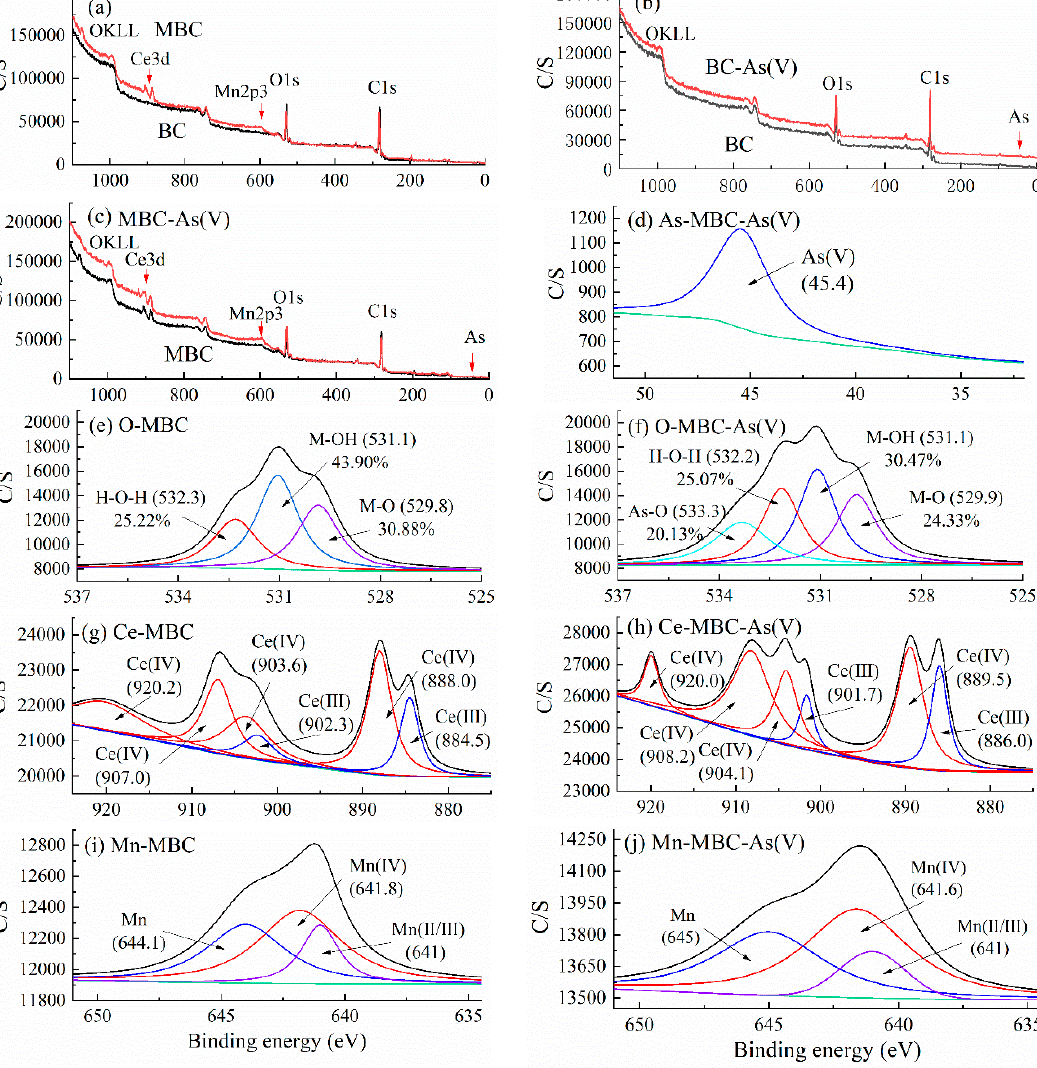
Figure 3. XPS spectra of BC and MBC. ( a ) BC, MBC, ( b ) BC, BC-As(V), ( c ) MBC, MBC-As(V), ( d ) As-MBC-As(V), ( e ) O-MBC, f : O-MBC-As(V), ( g ) Ce-MBC, ( h ) Ce-MBC-As(V), ( i ) Mn-MBC, ( j ) Mn-MBC-As(V).